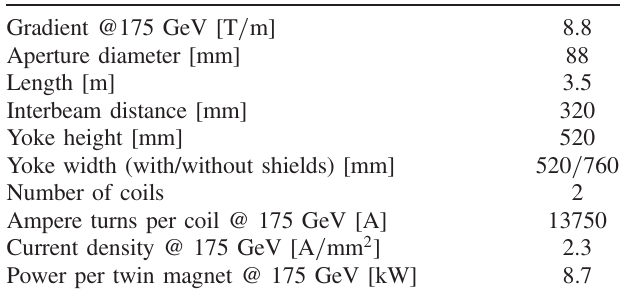
TABLE X. Main parameters of the FCC-ee twin